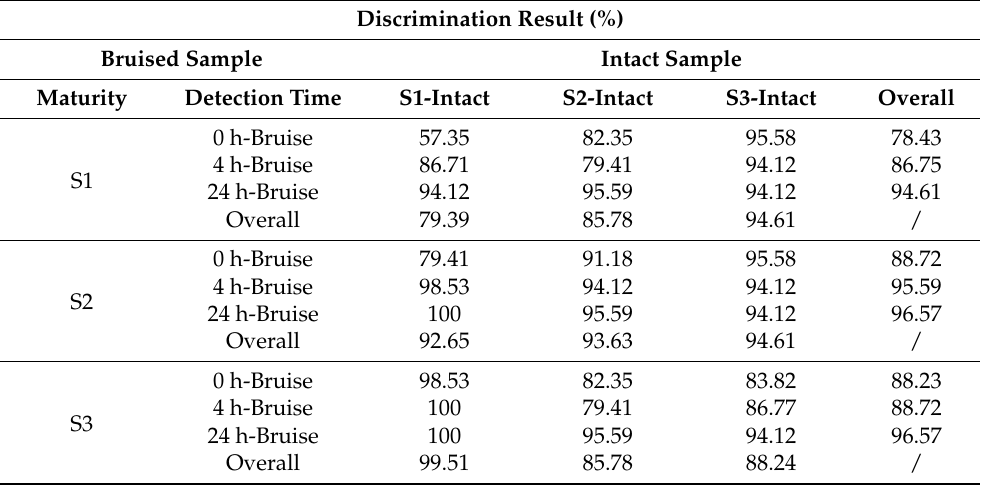
Table 5. Discrimination result between bruised samples and intact samples via Support Vector Machine (SVM) model using µ a over 550–1000